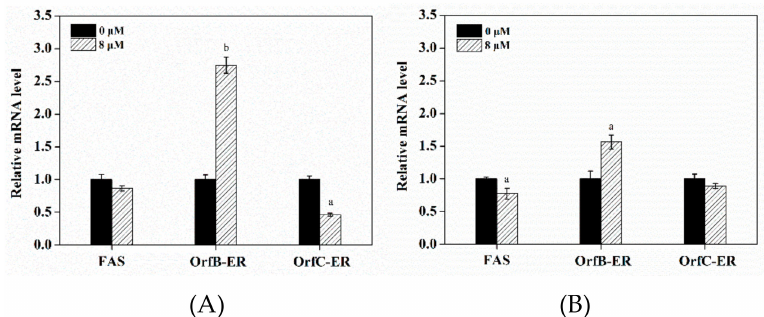
Figure 5. The gene expression profile of the fatty acid synthesis ( FAS ), OrfB-ER and OrfC-ER at ( A ) 48 h and ( B ) 72 h by RT-PCR from the control group and 8 µ M triclosan treatment group. FAS means fatty acid synthase, OrfB-ER means enyolreductase located on OrfB subunit, OrfC-ER means enyolreductase located on OrfC subunit. Significant di ff erence between the control and triclosan treatment group is indicated at p < 0.05 (a), p < 0.01 (b), or p < 0.001 (c) level. All data are expressed as mean ± S.D. of three independent experiments.